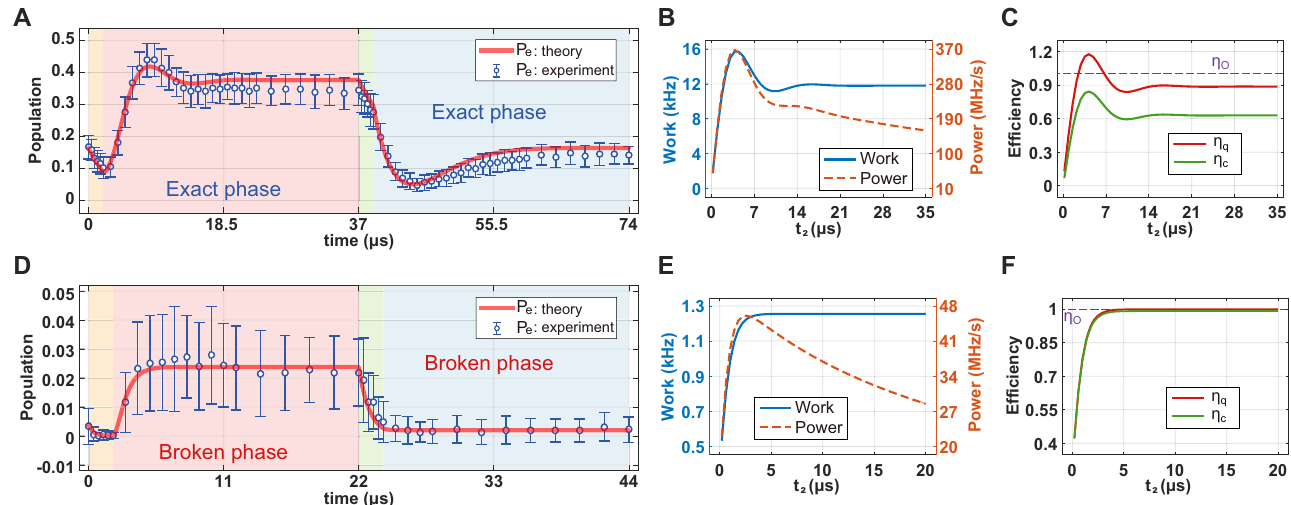
Fig. 2 | Otto cycles with the isochoric processes executed in the exact- or the broken-phase. A and D Time evolution of the population in the excited state ∣ e i when both the second (isochoric heating) and the fourth (isochoric cooling) strokes are in the exact (strong drive and oscillatory dynamics)- and broken (weak drive and non-oscillatory dynamics) phases, respectively. The red solid curves are obtained by simulating the master equation. The circles and the error bars, respectively, denote the average and standard deviation of 10,000 measurements. Regions with different colorscorrespond to different strokesofthe Otto cycle, with the orange, pink, green, and blue corresponding to the fi rst (adiabatic compression), second (isochoric heat- ing), third (adiabatic expansion), and fourth (isochoric cooling) strokes, respectively. The fi rst (orange) and the third (green) strokes are implemented by up- and down- scanning the detuning Δ between Δ min = 2 π =0 kHz, and Δ max = 2 π =10 kHz,